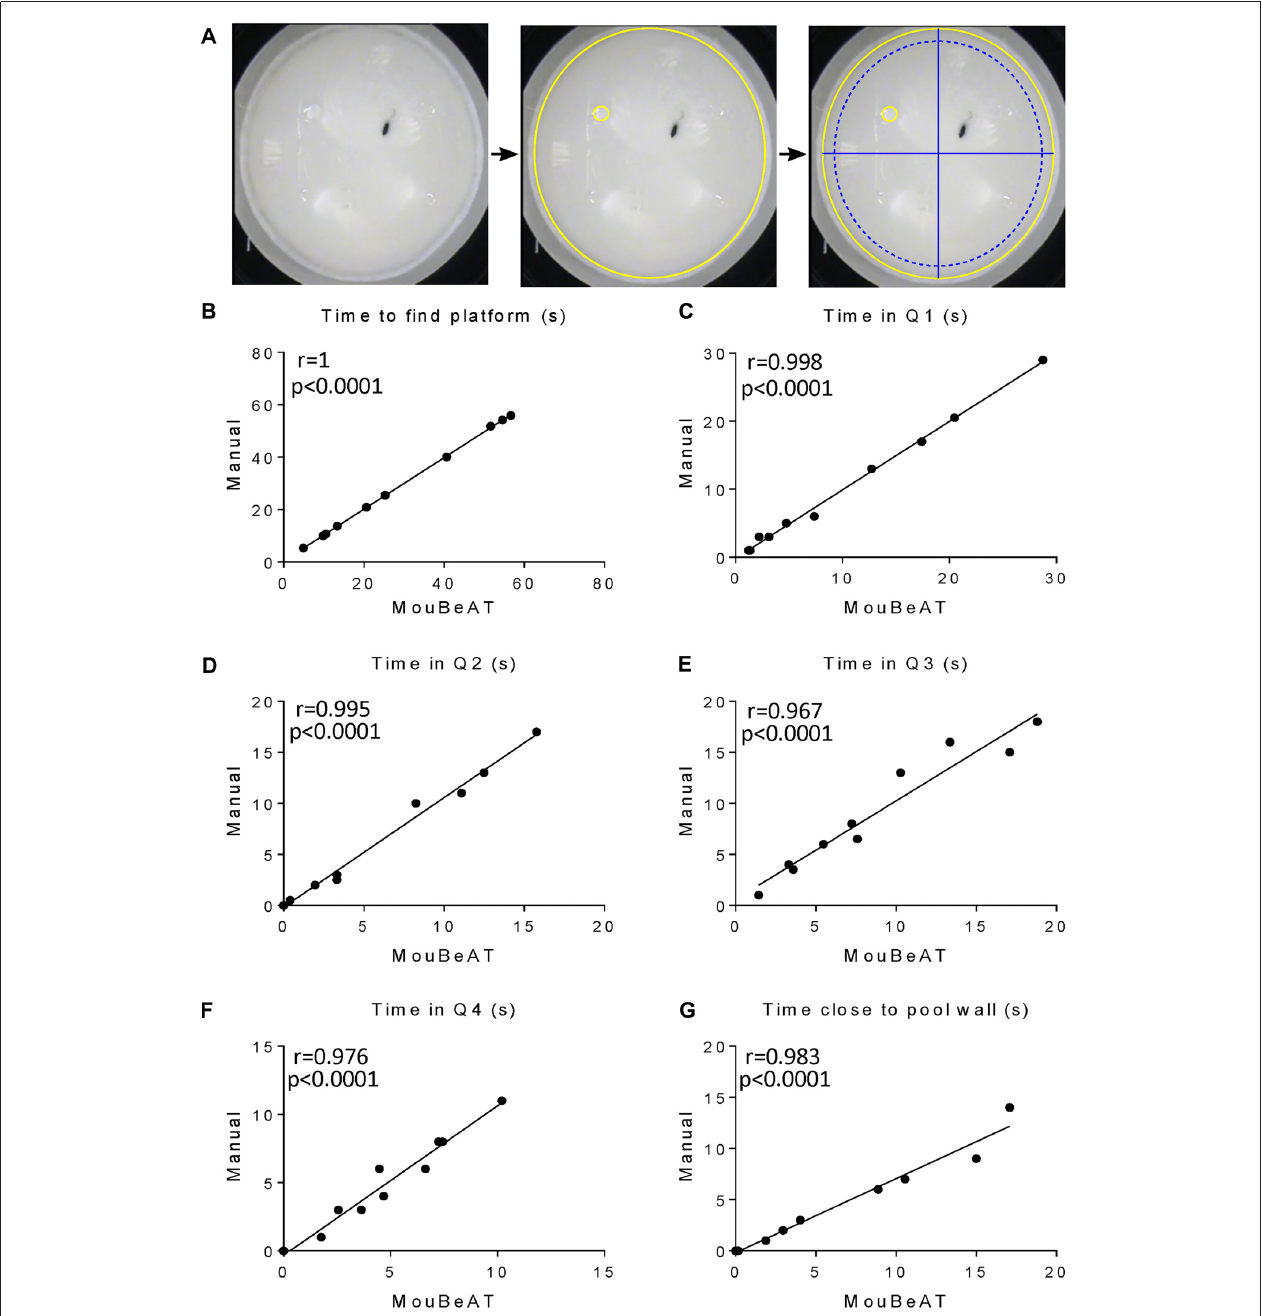
FIGURE 6 | Correlation between MouBeAT and manual assessment of different parameters in the Morris Water Maze (MWM) test. The MWM test (A) was performed on 10 C57BL/6J male mice. Yellow ROI defines the edges and the platform regions, while blue ROIs define the quadrants and the region close to the pool wall, calculated by the software. Each dot represents the time needed by the mouse to find the platform (B) , time in quadrants 1–4 (C–F) and the time spent close to the pool wall (G) for each